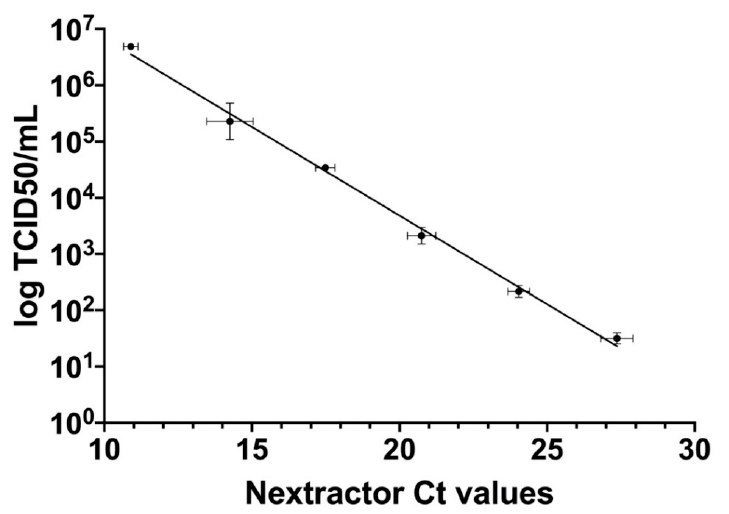
Figure 5. Correlation between TCID50/mL results (on a log10 scale) from titration on Vero E6 cells with the Reed and Muench method and Ct values derived from qRT-PCR with preliminary RNA extraction (Nextractor). Ct values are presented as the mean of six replicates for each dilution ± SE, whereas TCID50/mL values are presented as the mean of the two different methods (Reed and Muench and Karber) of two replicates for each dilution ± SE.